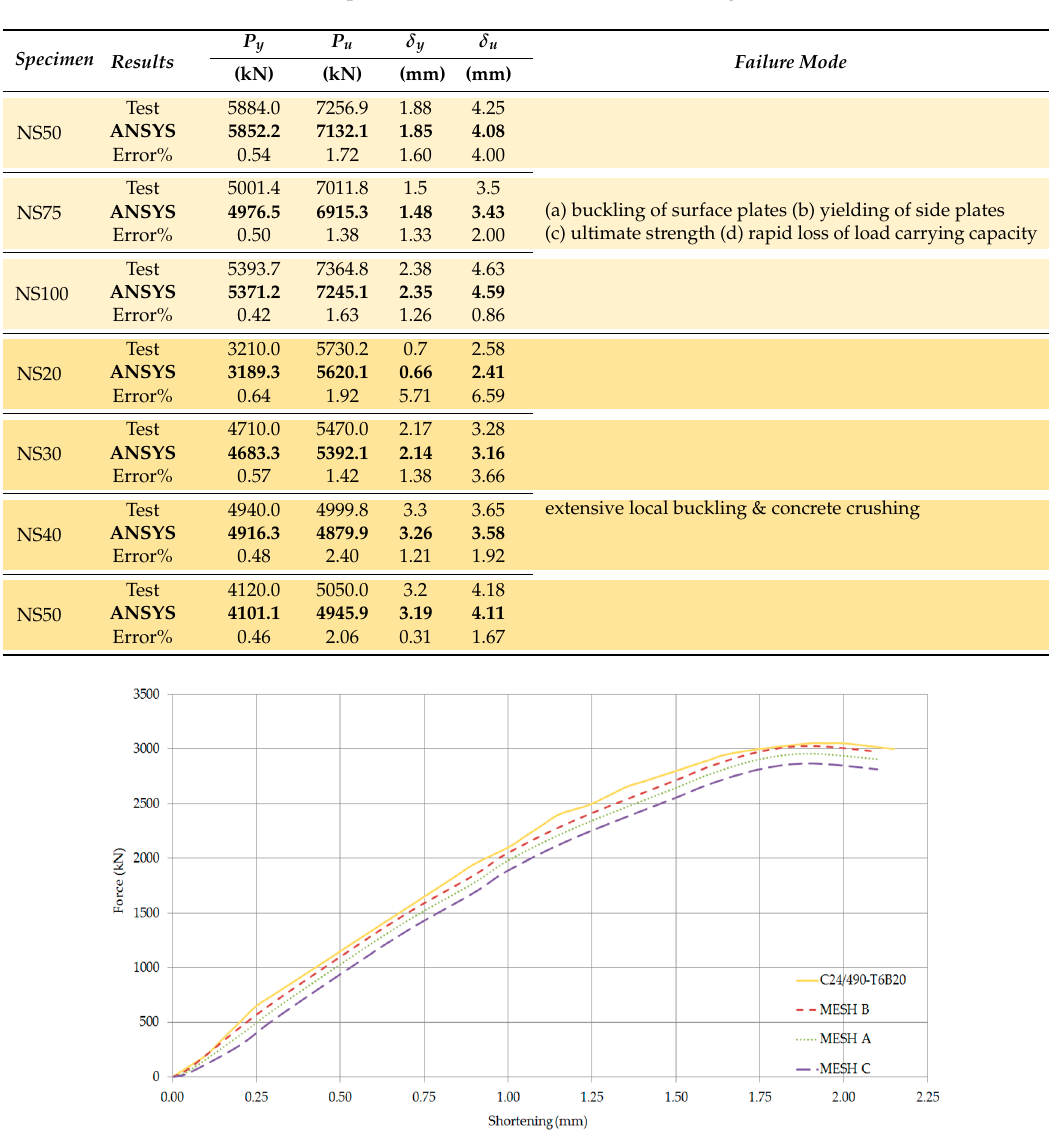
Figure 20. Axial force—Slip Curves of TS1-0.6 (Comparison of mesh densities).